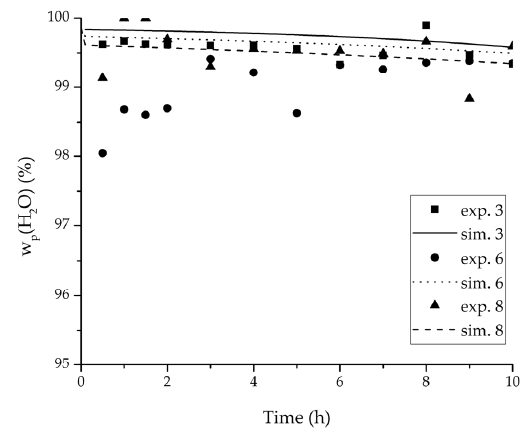
Figure 8. Experimental water mass fractions (feed) over time for three experiments used for the validation of the permeance function for ethanol/water compared with the corresponding simulation result.